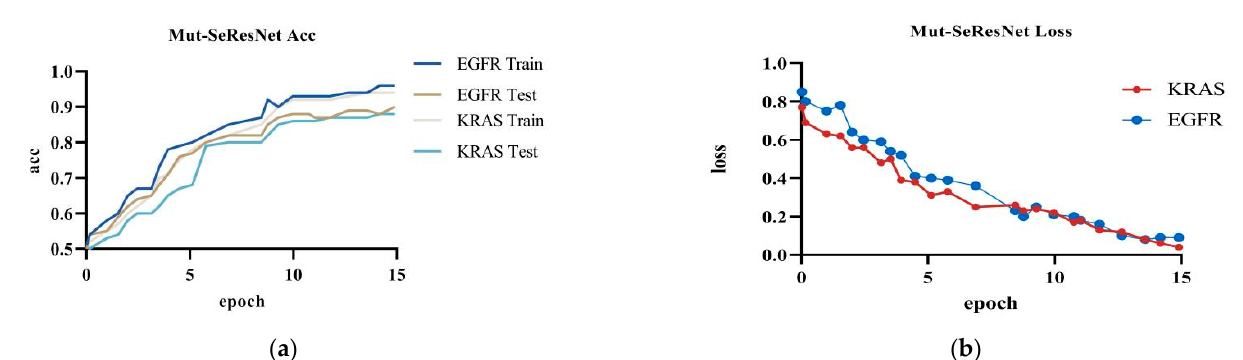
Figure 5. Mut-SeResNet: ( a ) the accuracy of Mut-ResNet in predicting EGFR and KRAS; ( b ) the loss of Mut-ResNet in predicting EGFR and KRAS genes.